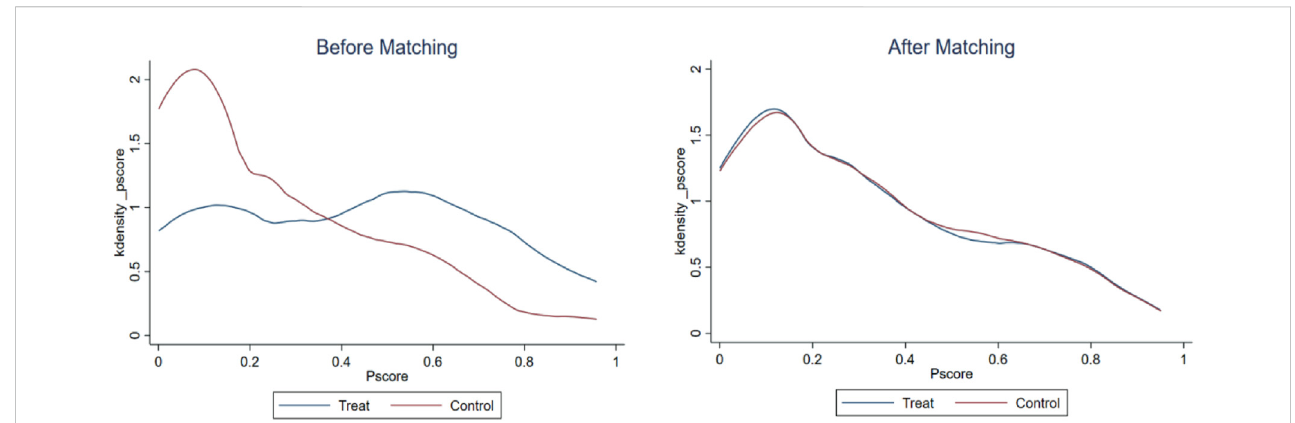
FIGURE 1 Probability distribution density function of the propensity score value. Source: Author ’ s estimation.